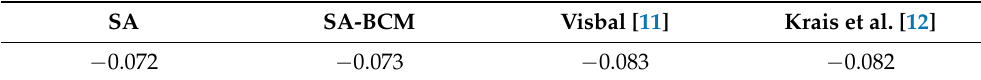
Table 1. Comparison of the mean drag coefficient C D between the different models, together with experimental and numerical reference data. SA SA-BCM Visbal [11] Krais et al. [12] − 0.072 − 0.073 − 0.083 − 0.082